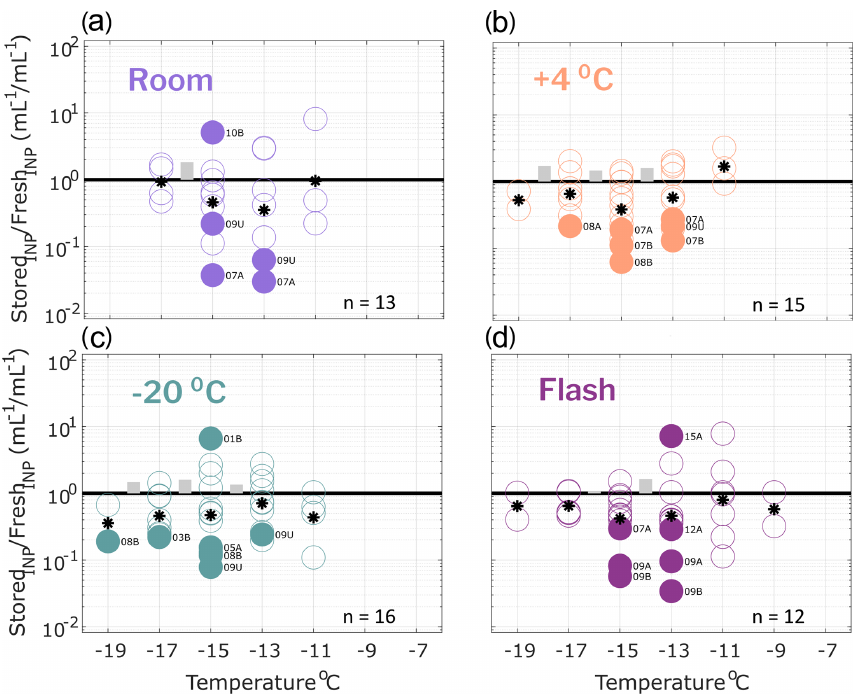
Figure 4. Ratio of INP concentrations measured in filtered (0.45µm) precipitation samples (stored:fresh), calculated in successive 2 ◦ C increments between − 19 and − 7 ◦ C. Same samples as in Fig. 2 but filtered with a 0.45µm syringe filter prior to measurement (see Methods Sect. 2.2 for details). All samples were processed at one or two time intervals between 1 and 166d postcollection. For samples processed at two intervals, both replicate samples are represented in the figure for a total of 13, 15, 16 and 12 samples in panels (a) , (b) , (c) and (d) , respectively (see Table 4 for summary of sample and replicate numbers). In temperature intervals containing stored:fresh ratios from at least two sets of replicate samples, grey bars represent the average difference between replicates. Results show significant losses of INPs in several filtered samples, regardless of storage